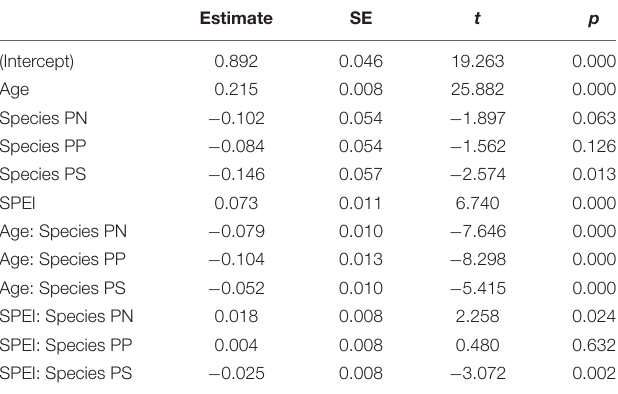
TABLE 2 | Summary of the linear mixed-effect model of